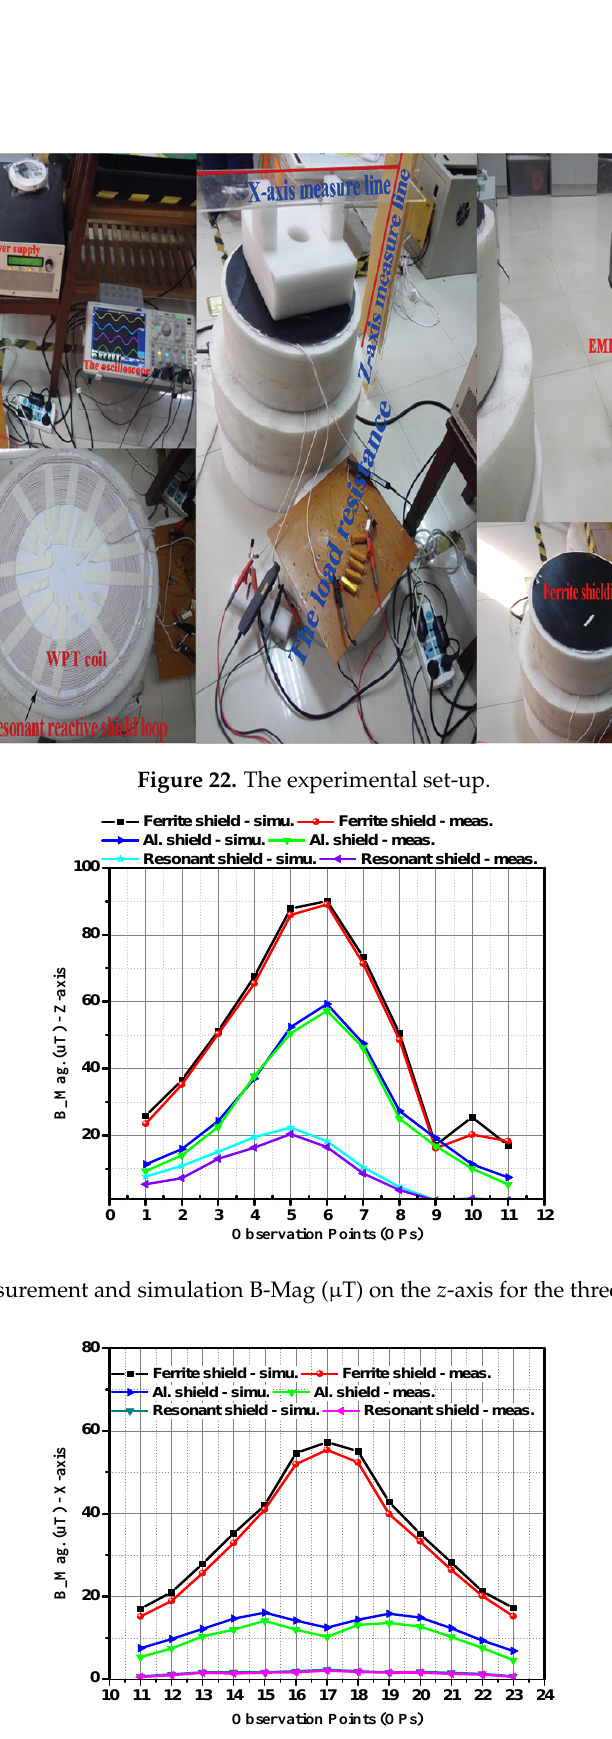
Figure 24. Measurement and simulation B-Mag ( µ T) on the x -axis for the three shielding